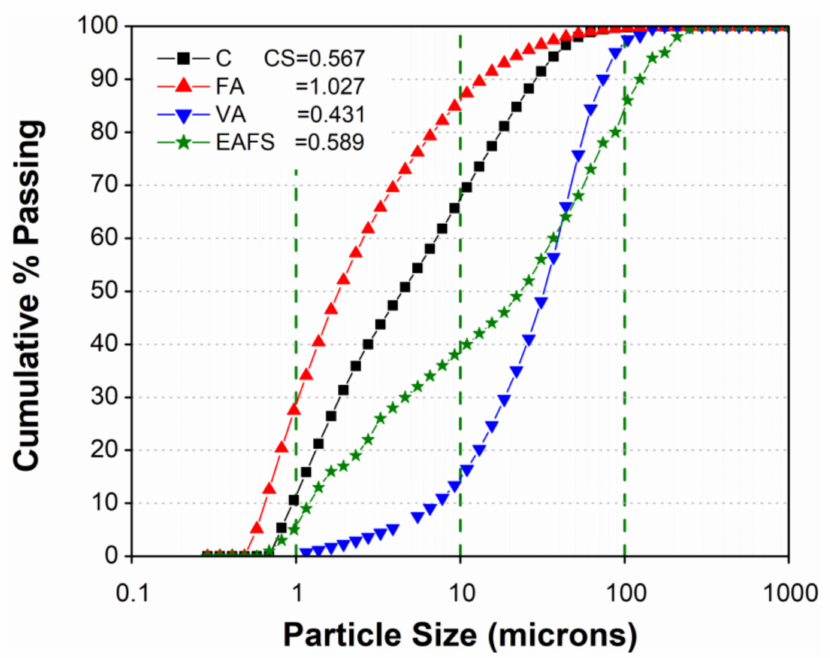
Figure 1. Particle size analysis curve of cement, volcanic ash, fly ash, and electric arc furnace slag. Table 2. Particle size distribution of cement, VA, FA, and EAFS used in preparation of